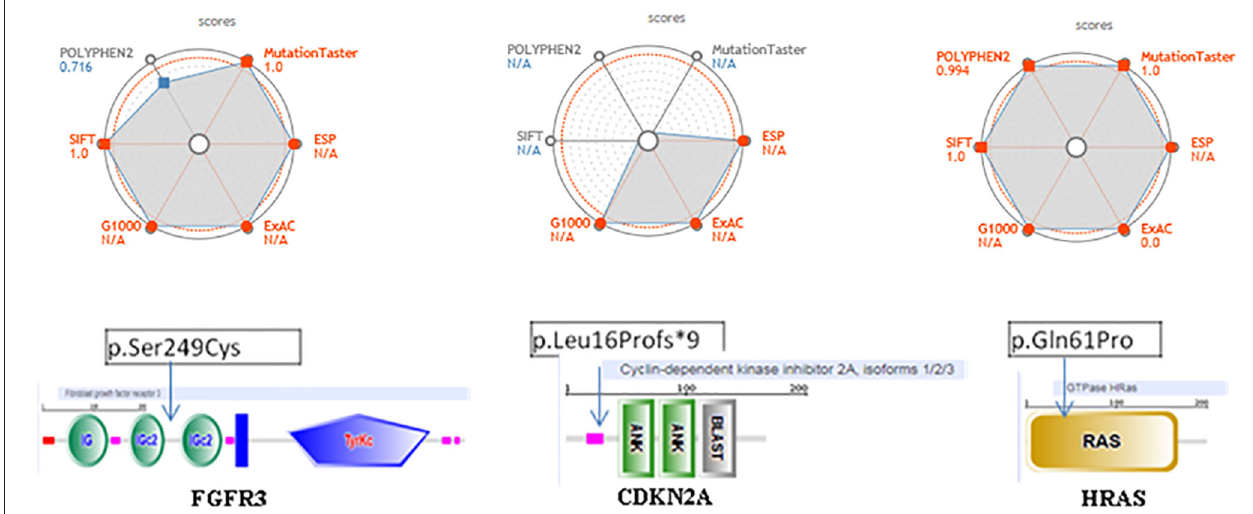
FIGURE 4 | Pathogenicity web plotting prediction scores for the three variants, FGFR3 (p.Ser249Cys) (left side), CDKN2A (p.Leu16Profs *9) (middle side), and HRAS (p.Gh161Pro) (right side). Values are scaled so that the most pathogenic scores are plotted toward the external circles. For POLYPHEN2, Mutation Taster and SIFT, those values approach 1; whereas for ESP, G1000, ExAC they approach. The greater the gray area, the variant is more likely pathogenic. ESP, G1000, ExAC empty values are considered as NIA. Score > 0.9 and population databases (if applicable) < 0.1 are shown in red. In the bottom, we show the localization on these three of genetic changes events FGFR3, CDKN2A, and HRAS using SMART